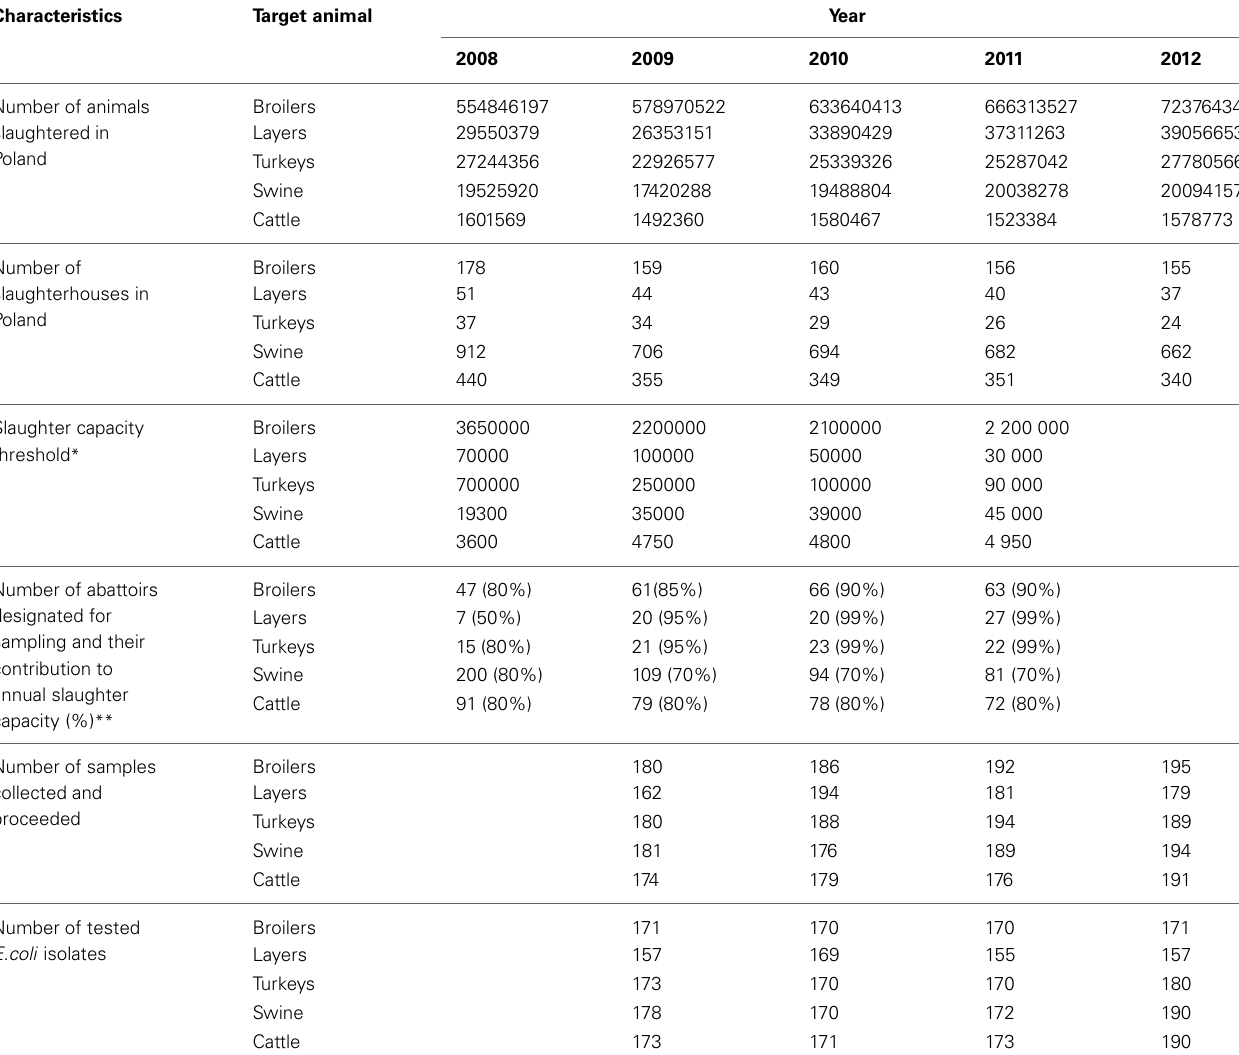
Table 1 | Descriptive characteristics of studied populations relevant for sampling planning, number of samples collected and E. coli isolates used in the